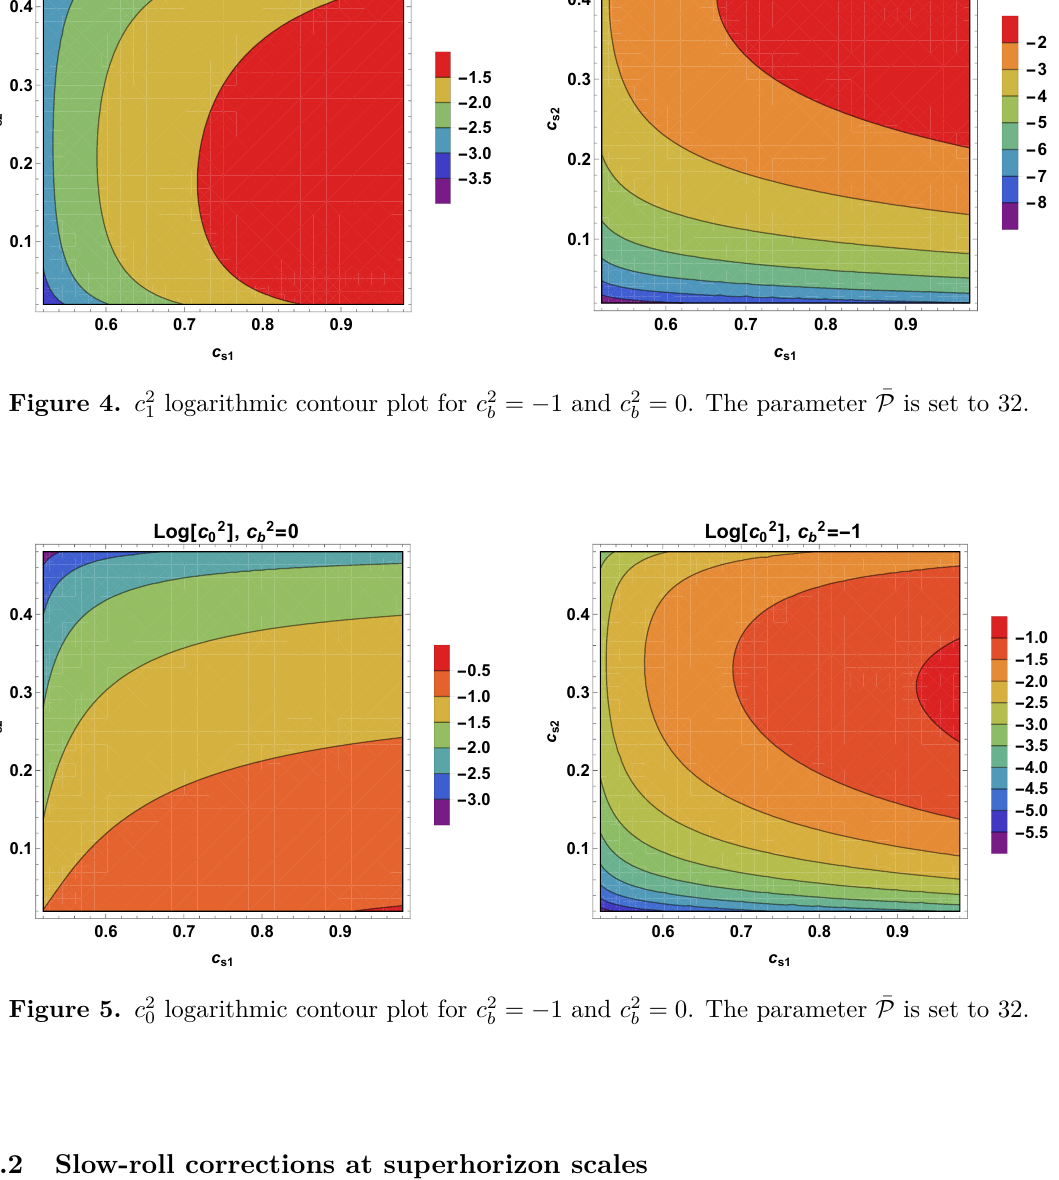
= − 1 and c 2 = 0 . The parameter ¯ P is set to 32 b b